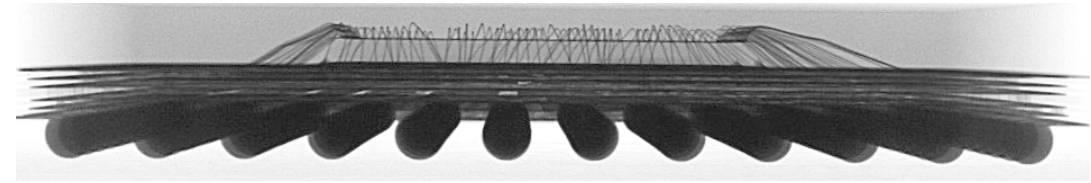
Figure 2. Side view: X-ray image of the AD9361.